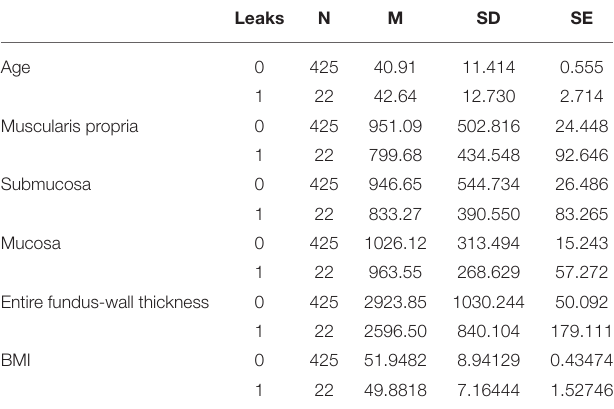
TABLE 3 | Correlation of leakage and gender.